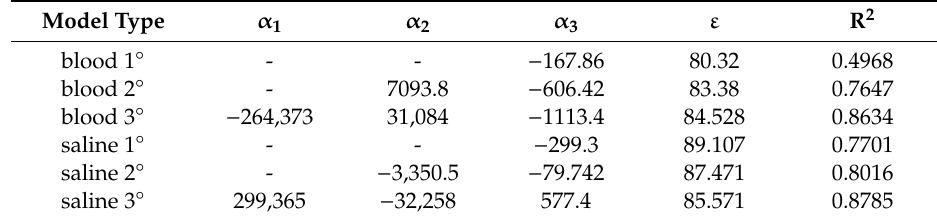
Table 4. Parameters of selected polynomial models— α 1 x 3 + α 2 x 2 + α 3 x + ε —obtained from the 0–6% data.